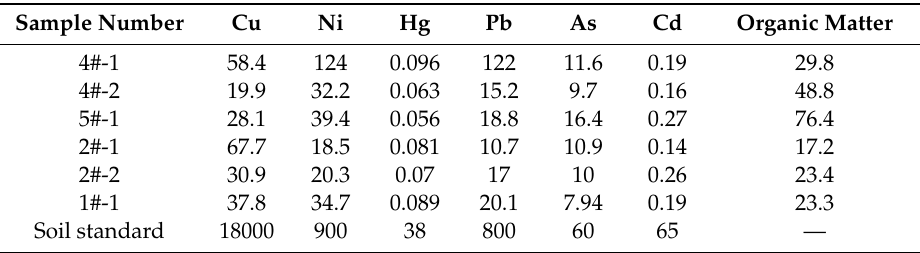
Table 3. Bottom sediment test results. Unit: mg · kg − 1